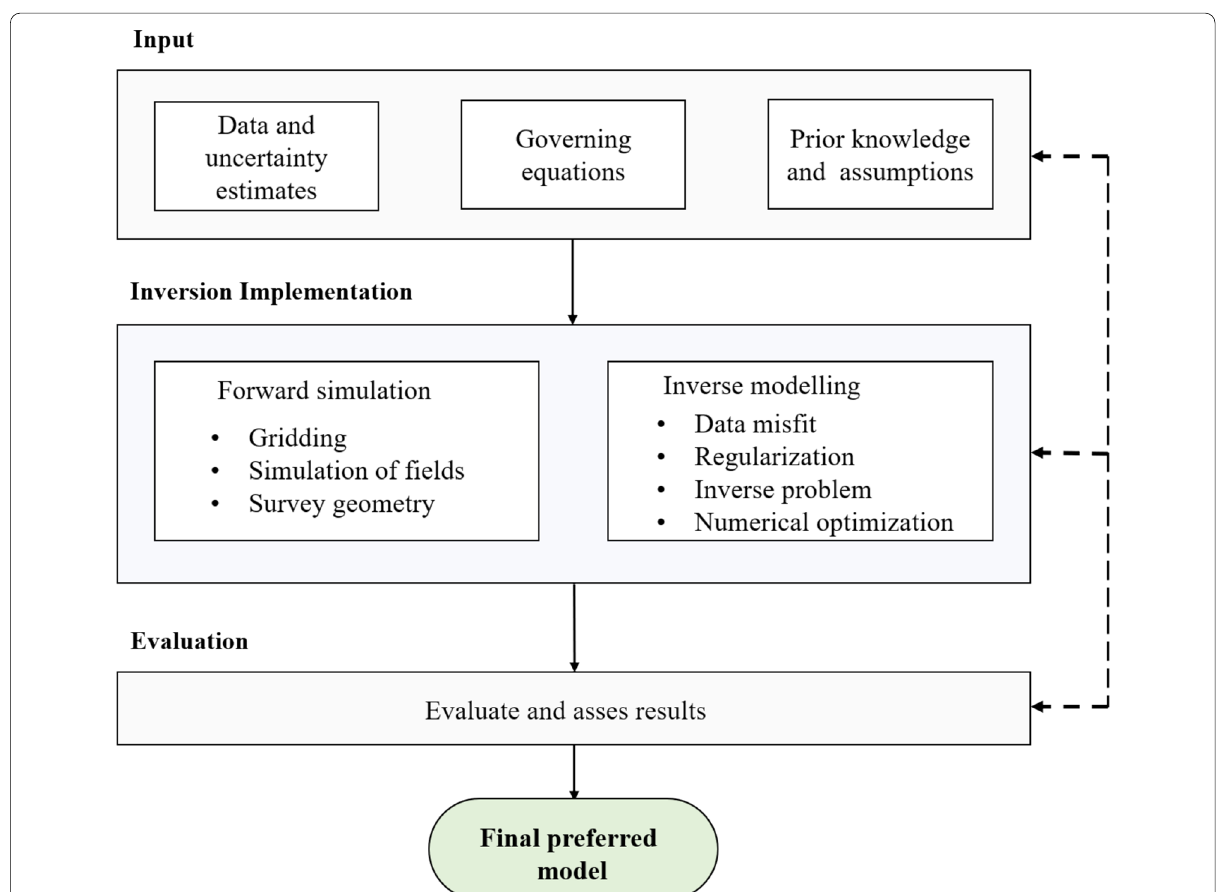
Fig. 4 SimPEG inversion procedure including inputs, implementation, evaluation and interpretation (Cockett et al. 2015)